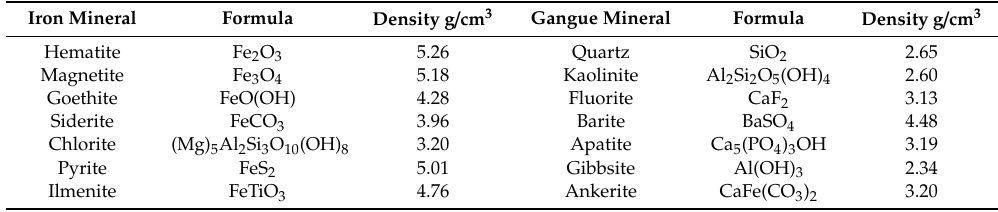
Table 5. Summary of common minerals in iron ores, alongside their formulae and density https: // www.mindat.org /